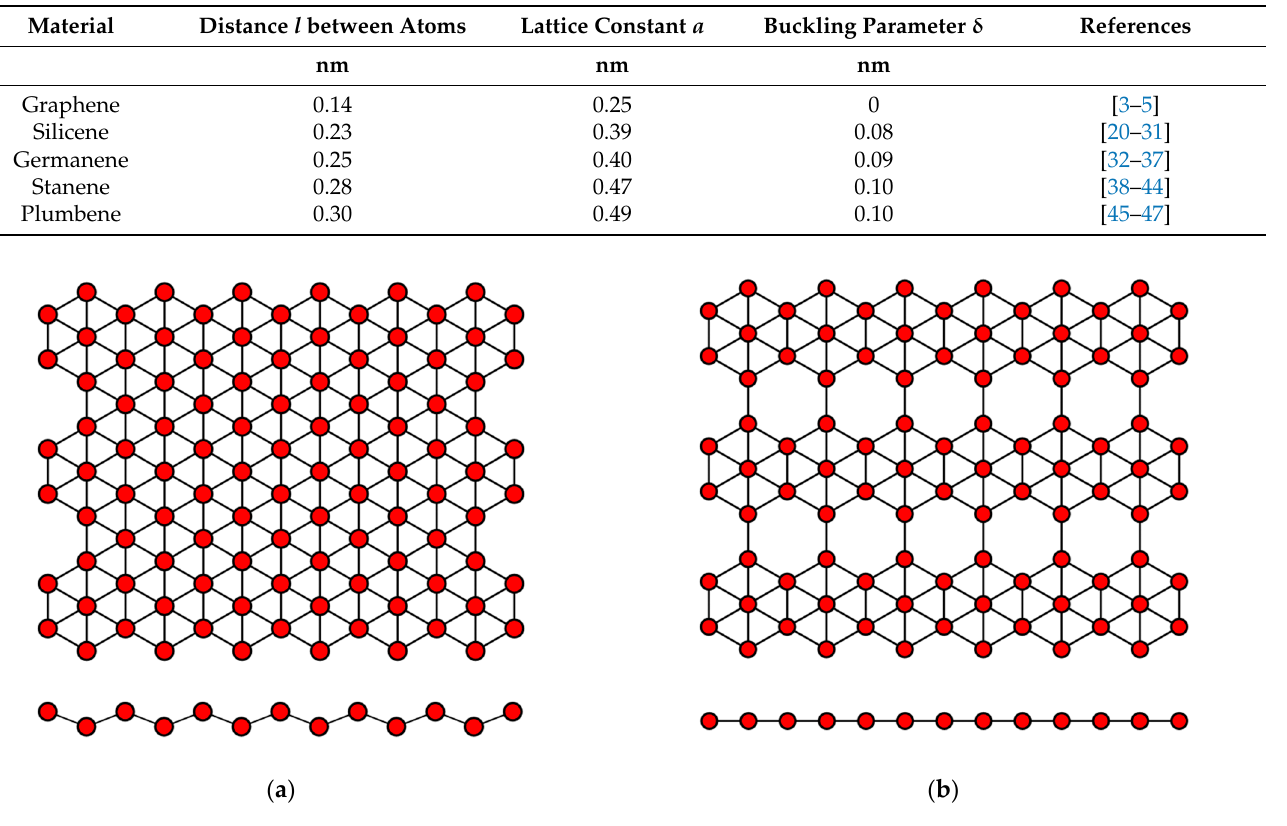
predict for a free-standing thallene l = 0.3 nm (Table